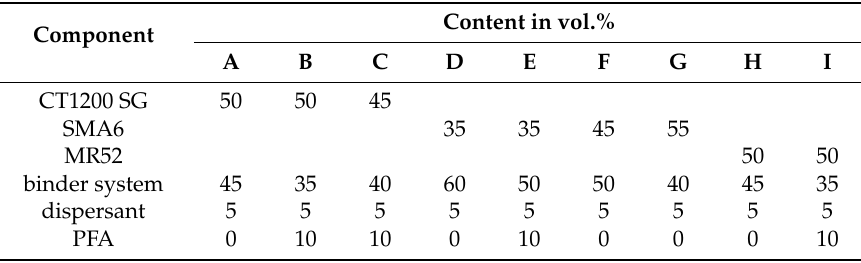
Table 2. Compositions of the prepared suspensions.